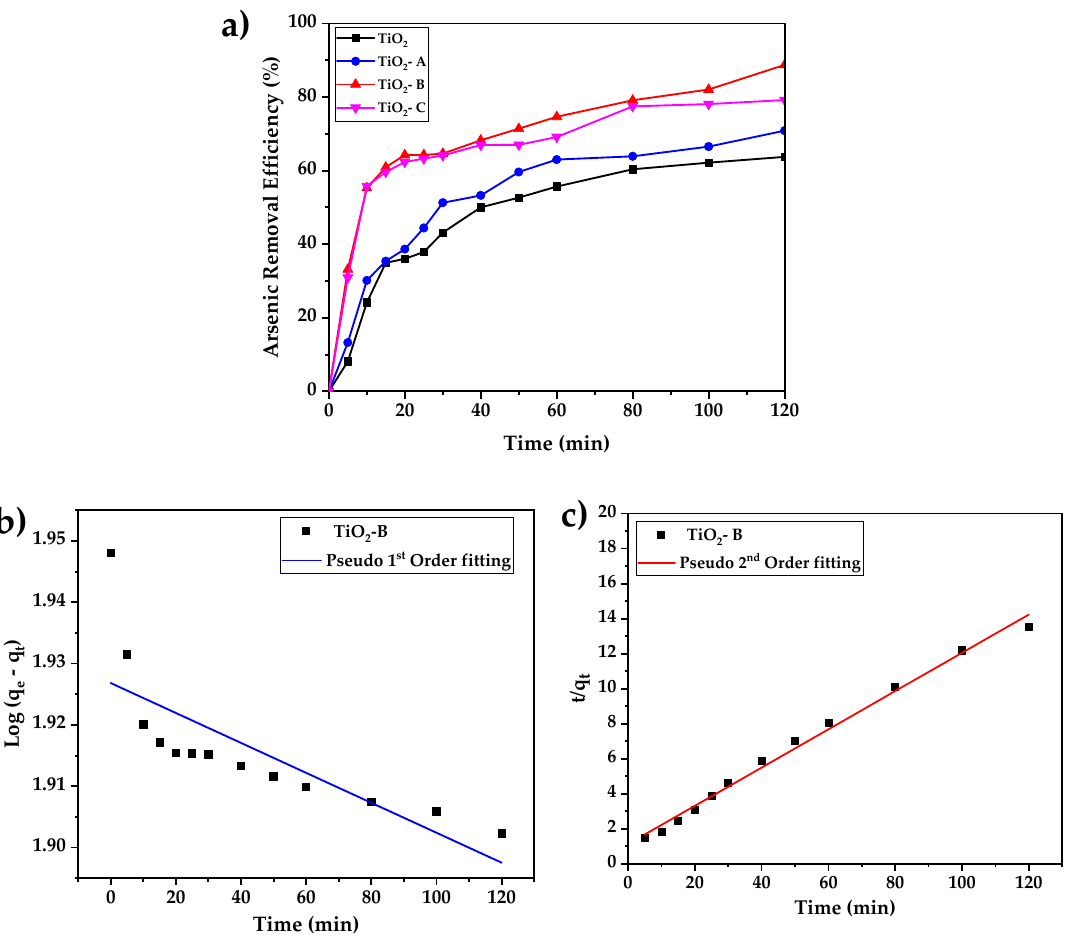
Figure 7. ( a ) Time-dependent adsorption of arsenic by pure and doped TiO 2 (initial concentration of arsenic 5 mg/L, adsorbent concentration 0.5 g/L and pH = 7), ( b ) linear fit of the kinetic adsorption using pseudo-first-order model, and ( c ) linear fit of the kinetic adsorption using pseudo-second- order model .